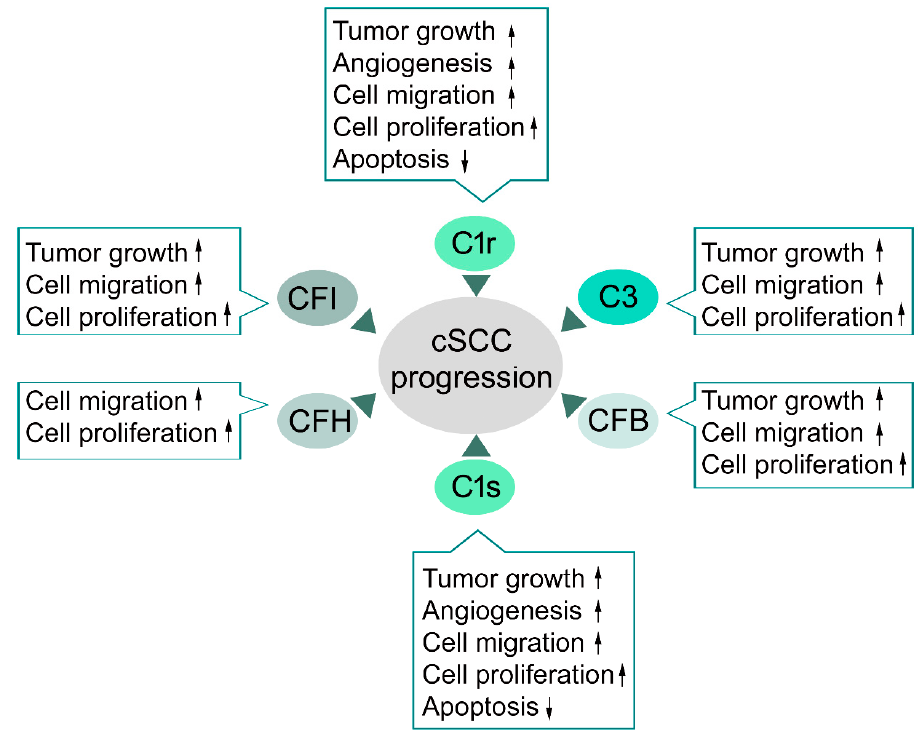
Figure 2. The role of tumor cell-derived complement components and inhibitors in cutaneous squamous cell carcinoma (cSCC). During progression of the cSCC complement factor H (CFH) and serine proteinases C1r, C1s, C3, CFB, and CFI exert e ff ects on cSCC cells other than those related to complement activation. C1r, C1s, C3, CFB, and CFI promote cSCC tumor growth in vivo. C1r and C1s promote angiogenesis in cSCC tumors in vivo. C1r, C1s, C3, CFB, CFI, and CFH increase proliferation and viability of cSCC cells. C1r and C1s inhibit apoptosis of cSCC cells. The migration of cSCC cells is stimulated by C3, CFB, CFI, CFH, C1r, and C1s. ↑ indicates stimulation, ↓ indicates